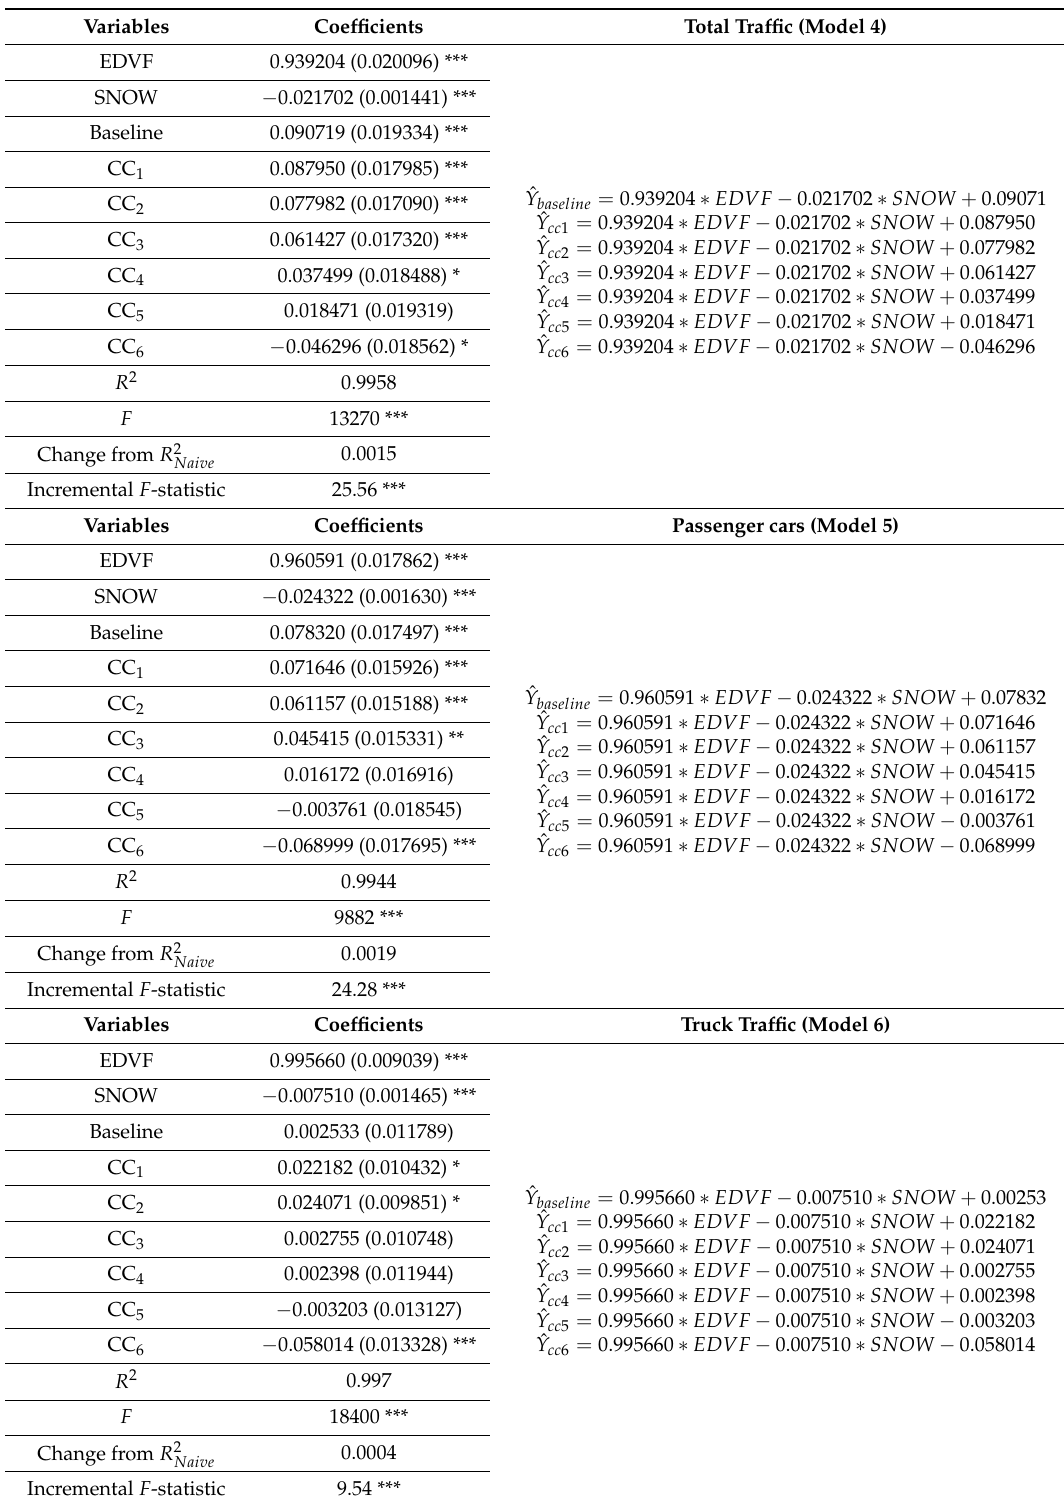
Table 3. Daily winter weather regression models with dummy variables at Leduc Hwy